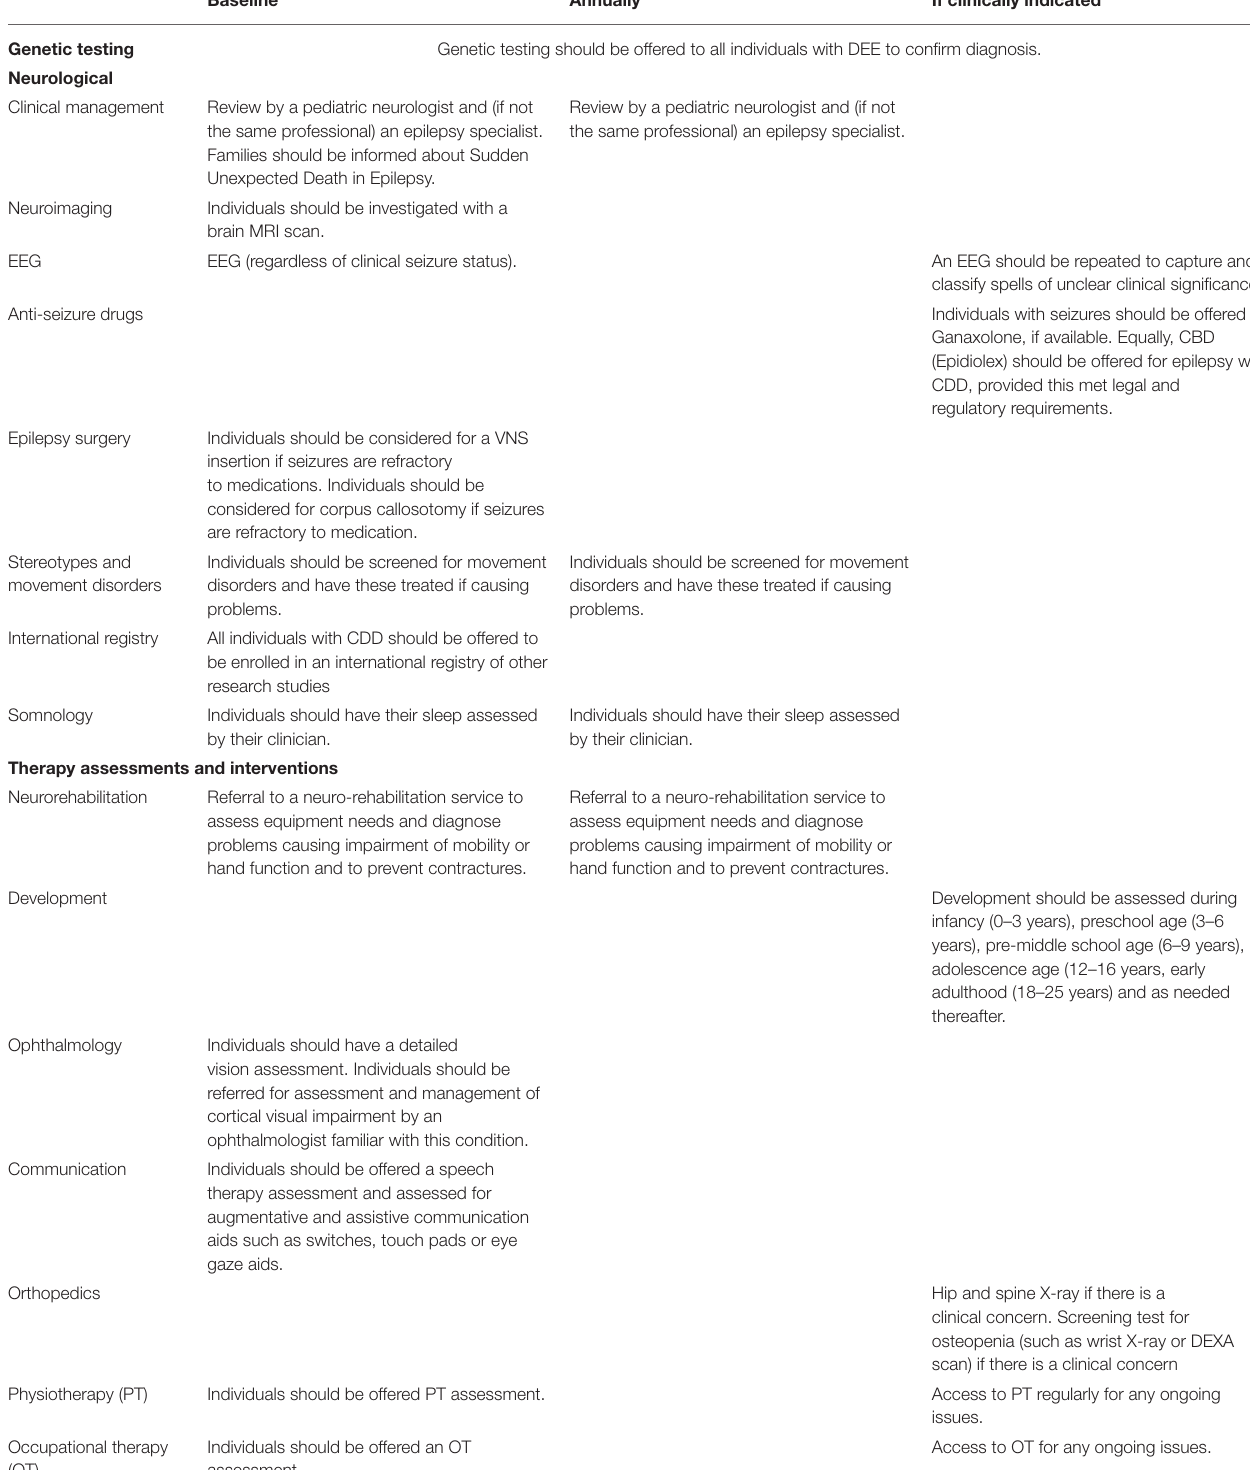
TABLE 1 | Recommendations for the management of individuals with CDD with suggested timepoints for completion.